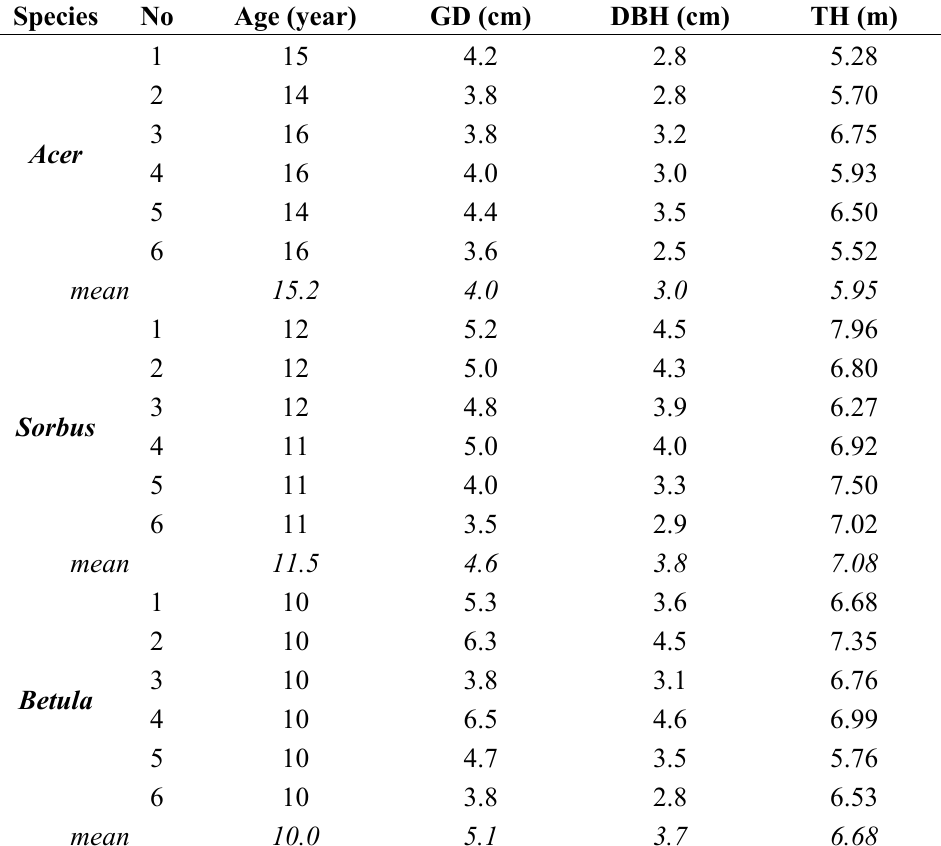
Table 1. Descriptive statistics for the 18 target trees: tree age (Age), ground diameter (GD), diameter at breast height (DBH) and total tree height